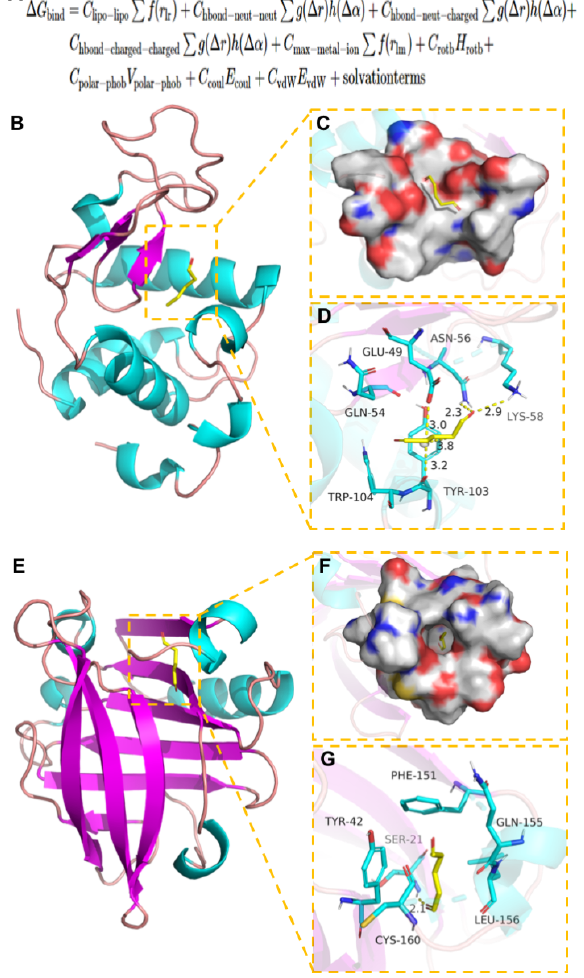
Figure 4. The binding mode of α -LA and β -LG proteins with GTA. ( A ) The Binding energy function. ( B ) The 3D structure of complex. ( C ) The surface of active site. ( D ) The detail binding mode of complex. GTA compound is showed in yellow. Yellow dash represents hydrogen bond distance or π -stacking. ( E ) The 3D structure of complex. ( F ) The surface of active site. ( G ) The detail binding mode of complex. GTA compound is showed in yellow. Yellow dash represents hydrogen bond distance.